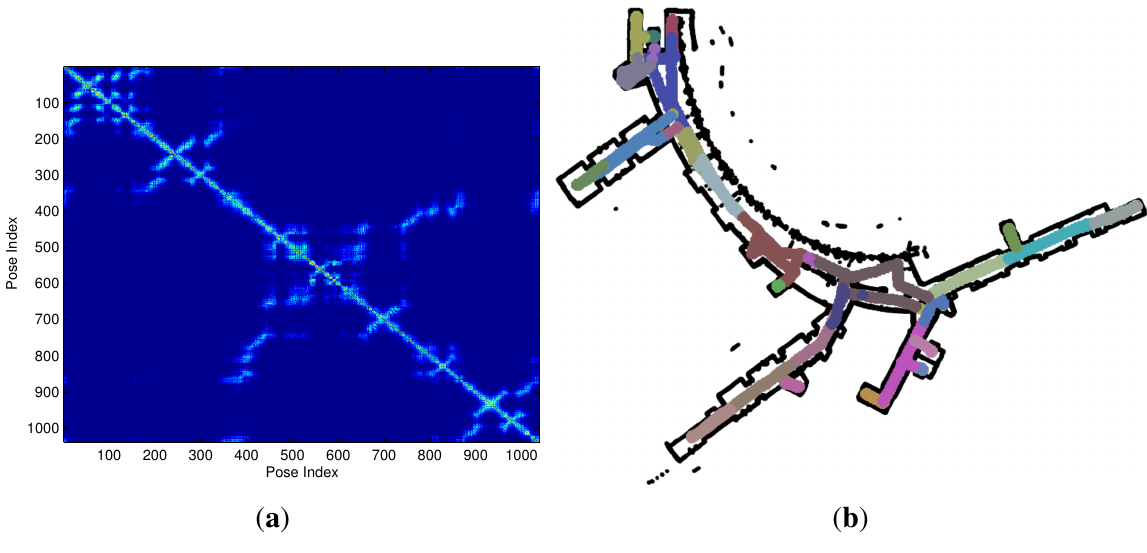
Figure 8. ( a ) Correlation matrix formed from the occupancy grid map of Figure 7b. ( b ) The results of clustering the correlation matrix from